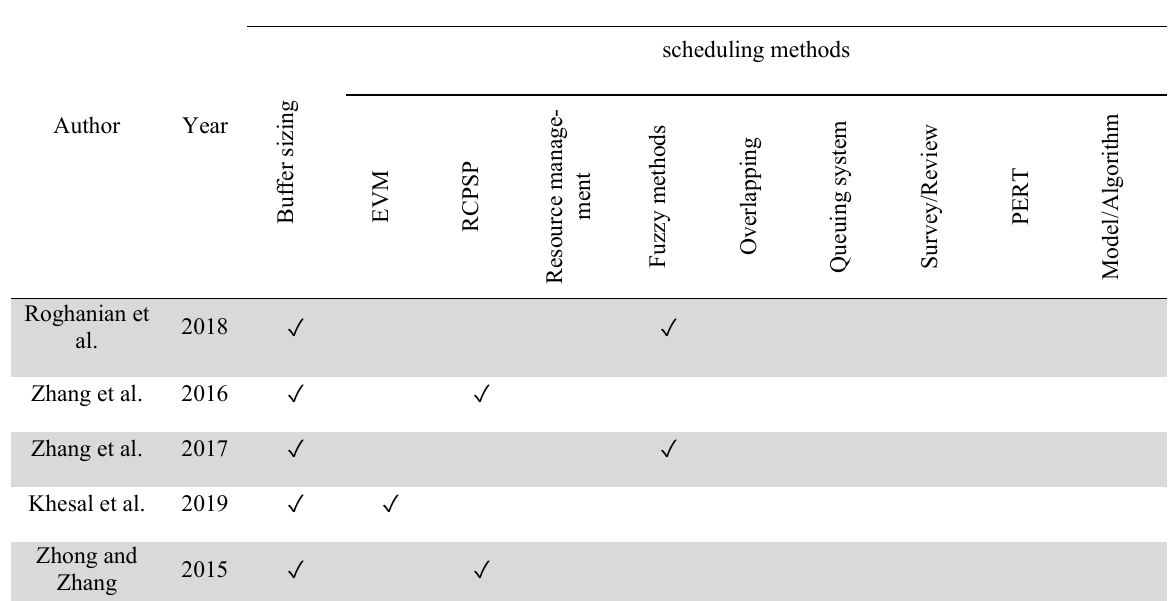
Project buffer sizing: scheduling